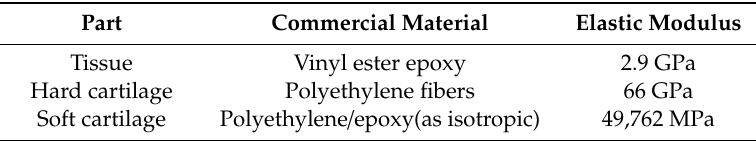
Table 1. Commercial materials selected to model the rostrum.